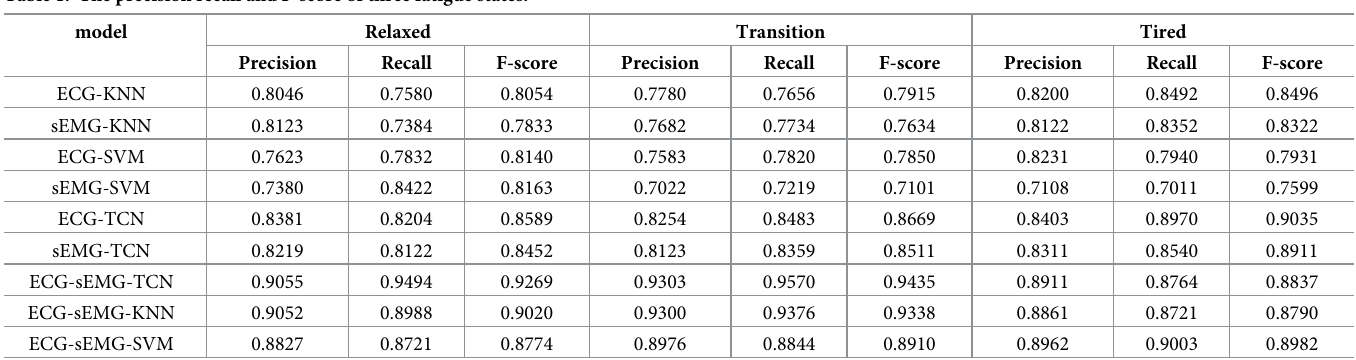
accuracy was found in the ECG-SEMG-KNN model (66%, 65%, 65%). There was no particu-